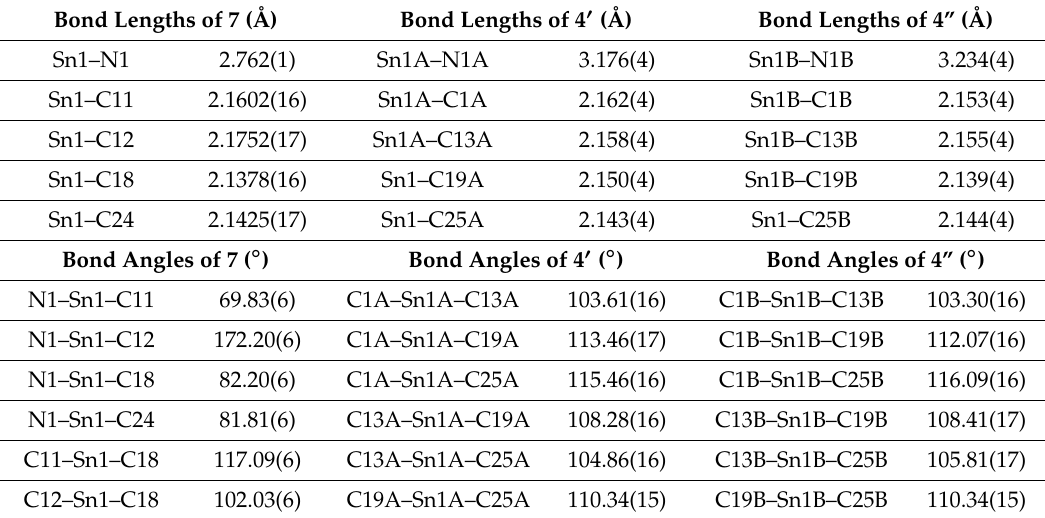
Table 1. Selected structural data for 7 , 4 ′ , and 4 ″ .